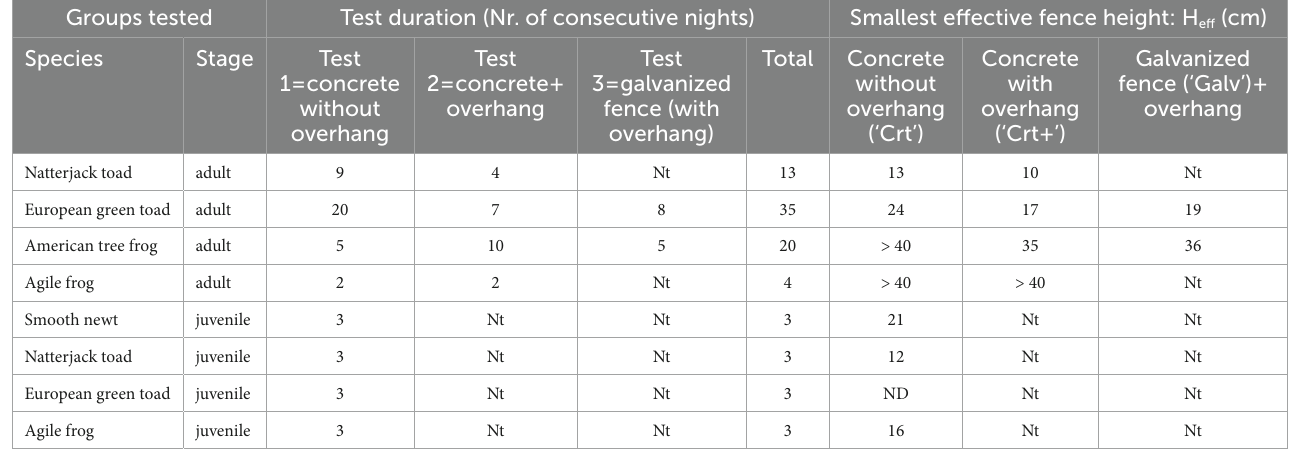
TABLE 2 Summary of experimental trials according to species and development stage. Groups